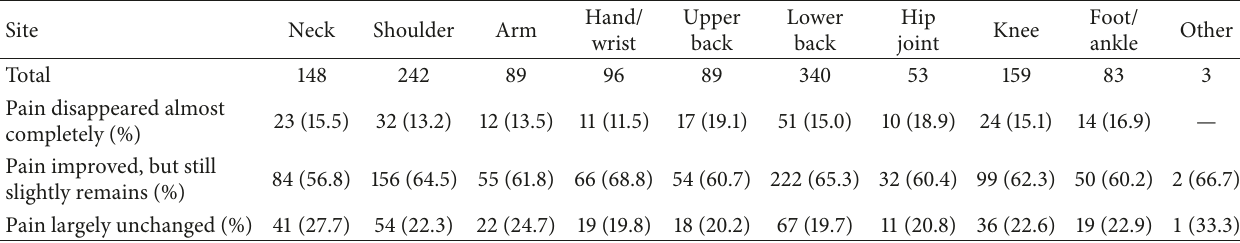
Table 4: Patient survey: extent of pain improvement by site